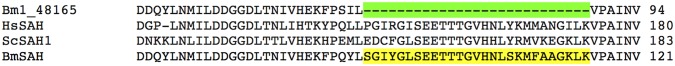
Partial CLUSTAL 2.1 multiple sequence alignment of publicly available Brugia malayi (Bm1_48165), Homo sapiens (HsSAH), Saccharomyces cerevisiae (ScSAH), and our cloned Brugia malayi (BmSAH) S-adenosyl homocysteinases, showing the “insert” missing from the publicly available nematode protein sequence.The absence of the 27 amino acids in the publicly available Brugia sequence (Bm1_48165) could indicate a splice variant of the enzyme or simply a problem with the genome assembly.